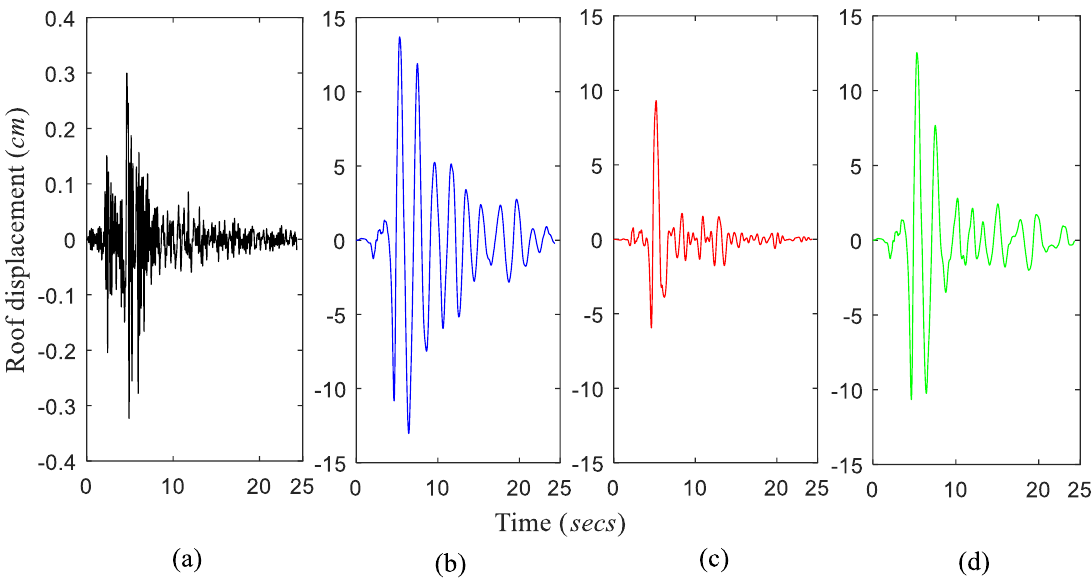
Fig. 9. Time history of roof relative displacement of (a) Fixed base (b) Isolated base with LRB (c) Isolated base with LPB (d) Isolated base with LRB and TMD structures under Chamoli earthquake.